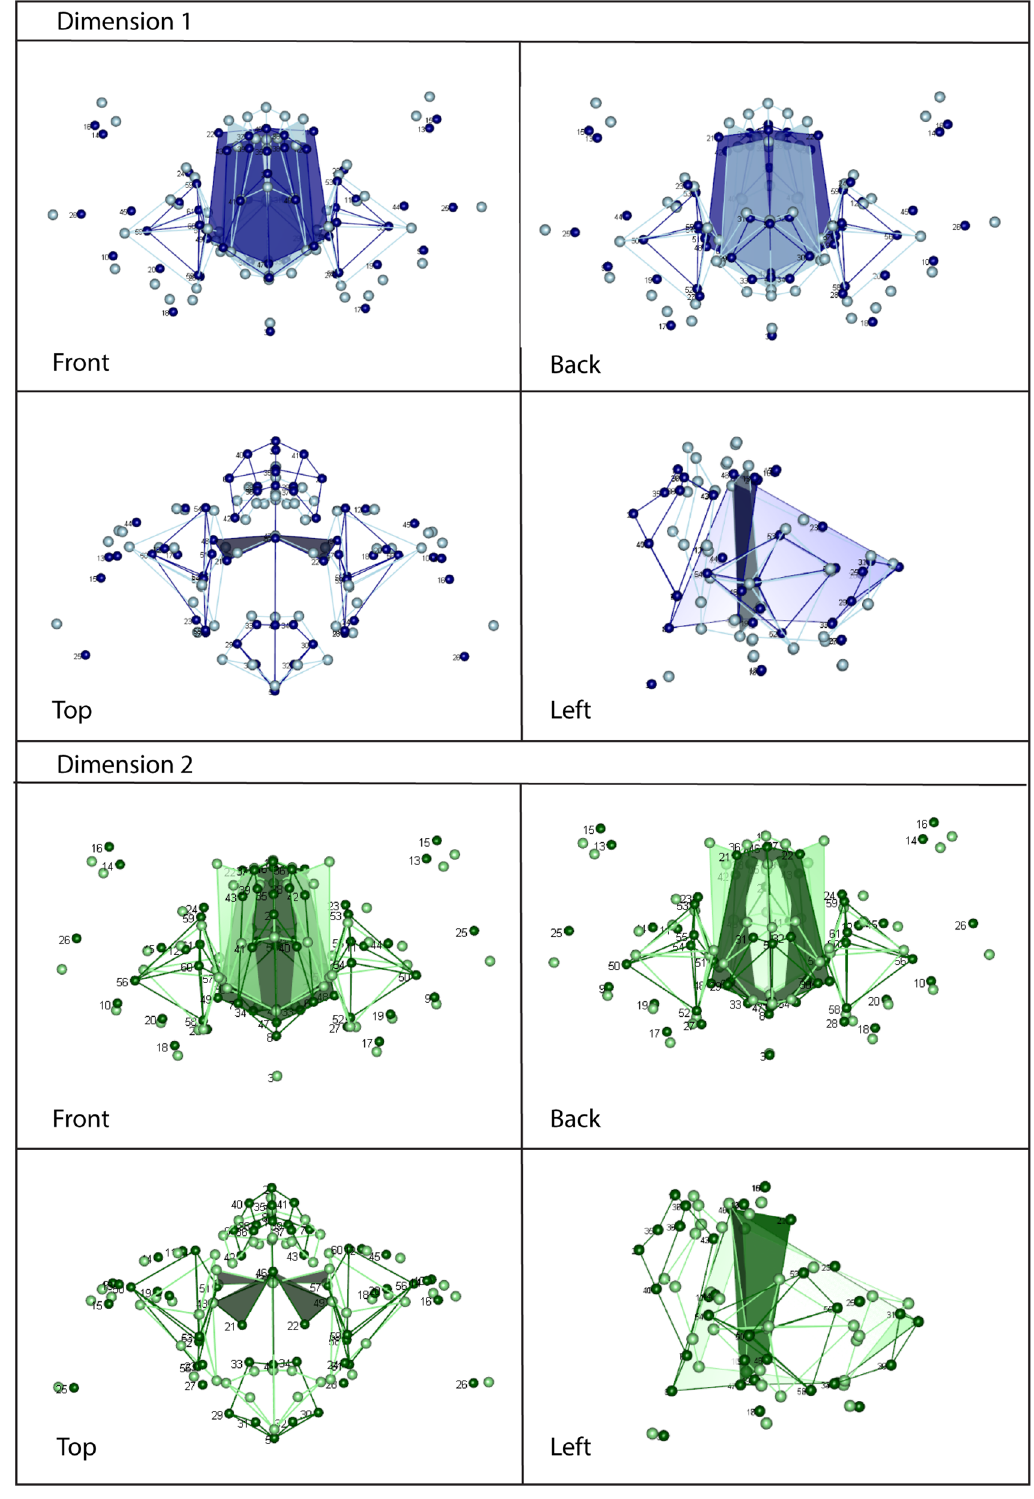
Figure 2. Face shape described by the first dimensions of the reduced rank regression. Dimension 1: Dark blue wireframes correspond to warmer climates and light blue wireframes to colder climates. Dimension 2: Dark green wireframes correspond to drier climates and light green ones to more humid climates. In both cases, shaded surfaces represent the internal nose